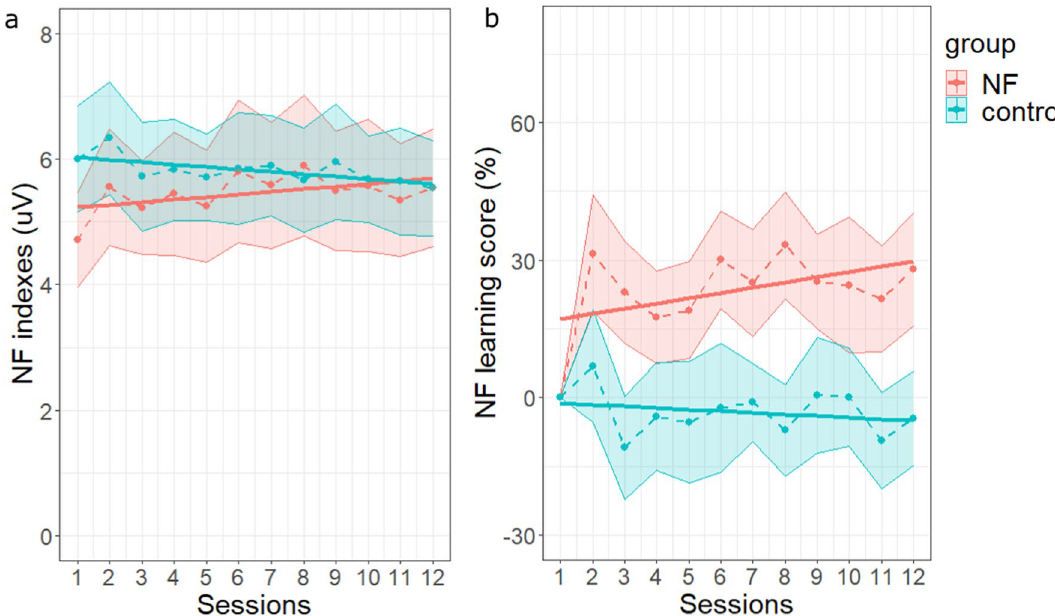
Figure 3. Neuromodulation induced by NFT. ( a ) Evolution of the NF index across sessions, for the NF (in red) and the control (in blue) groups. ( b ) Evolution of the NF learning score across sessions. In both subplots, dotted lines and points represent the values of the NF index along the 12 sessions, averaged across participants for each group; the shaded areas represent the standard errors of the means. The solid lines represent the session effect estimated for each group from the LMM. Graphs were obtained with R software (v.4.0.2; R Core Team,